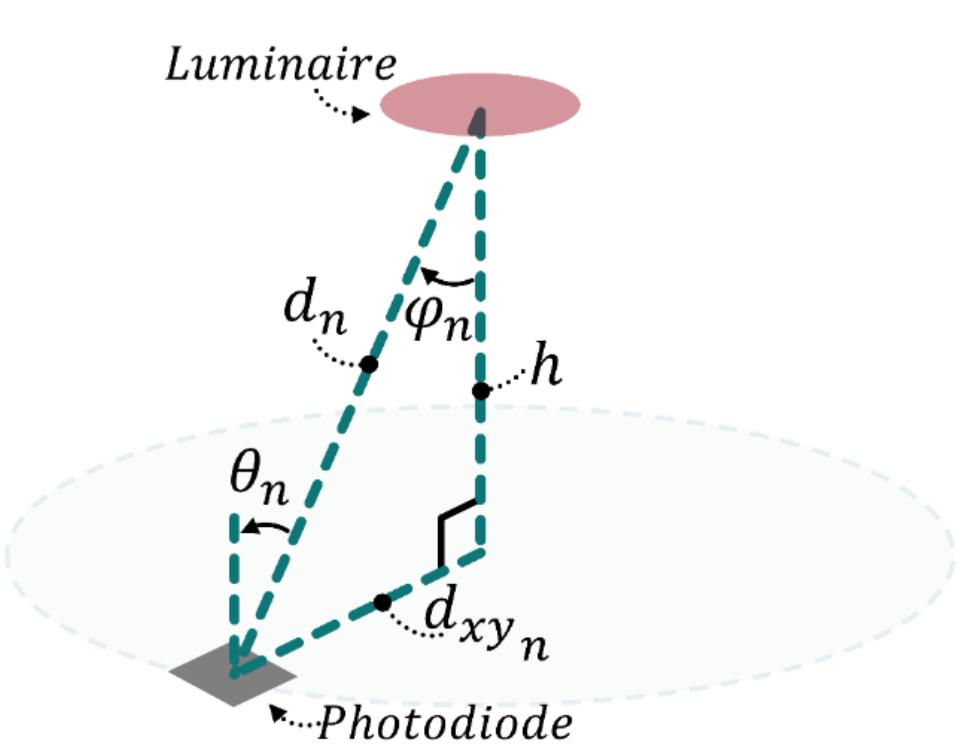
Figure 16. When both the luminaire and receiver are horizontal, θ n and ϕ n are equal, and d n then forms the hypotenuse of a right-angle triangle.